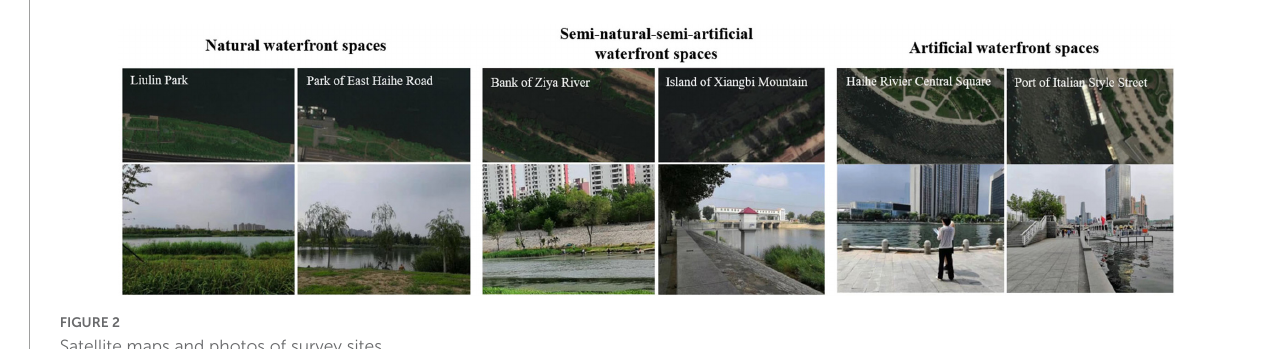
FIGURE2 Satellite maps and photos of survey sites.